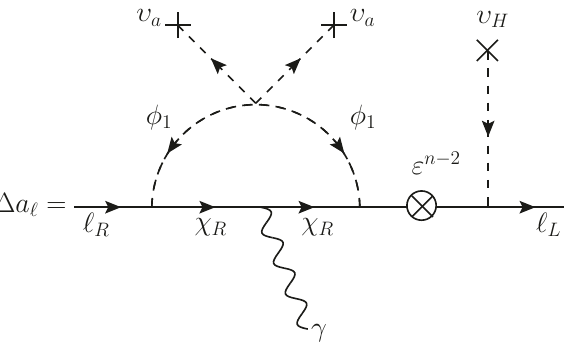
Figure 2 . Flavon contribution to ( g